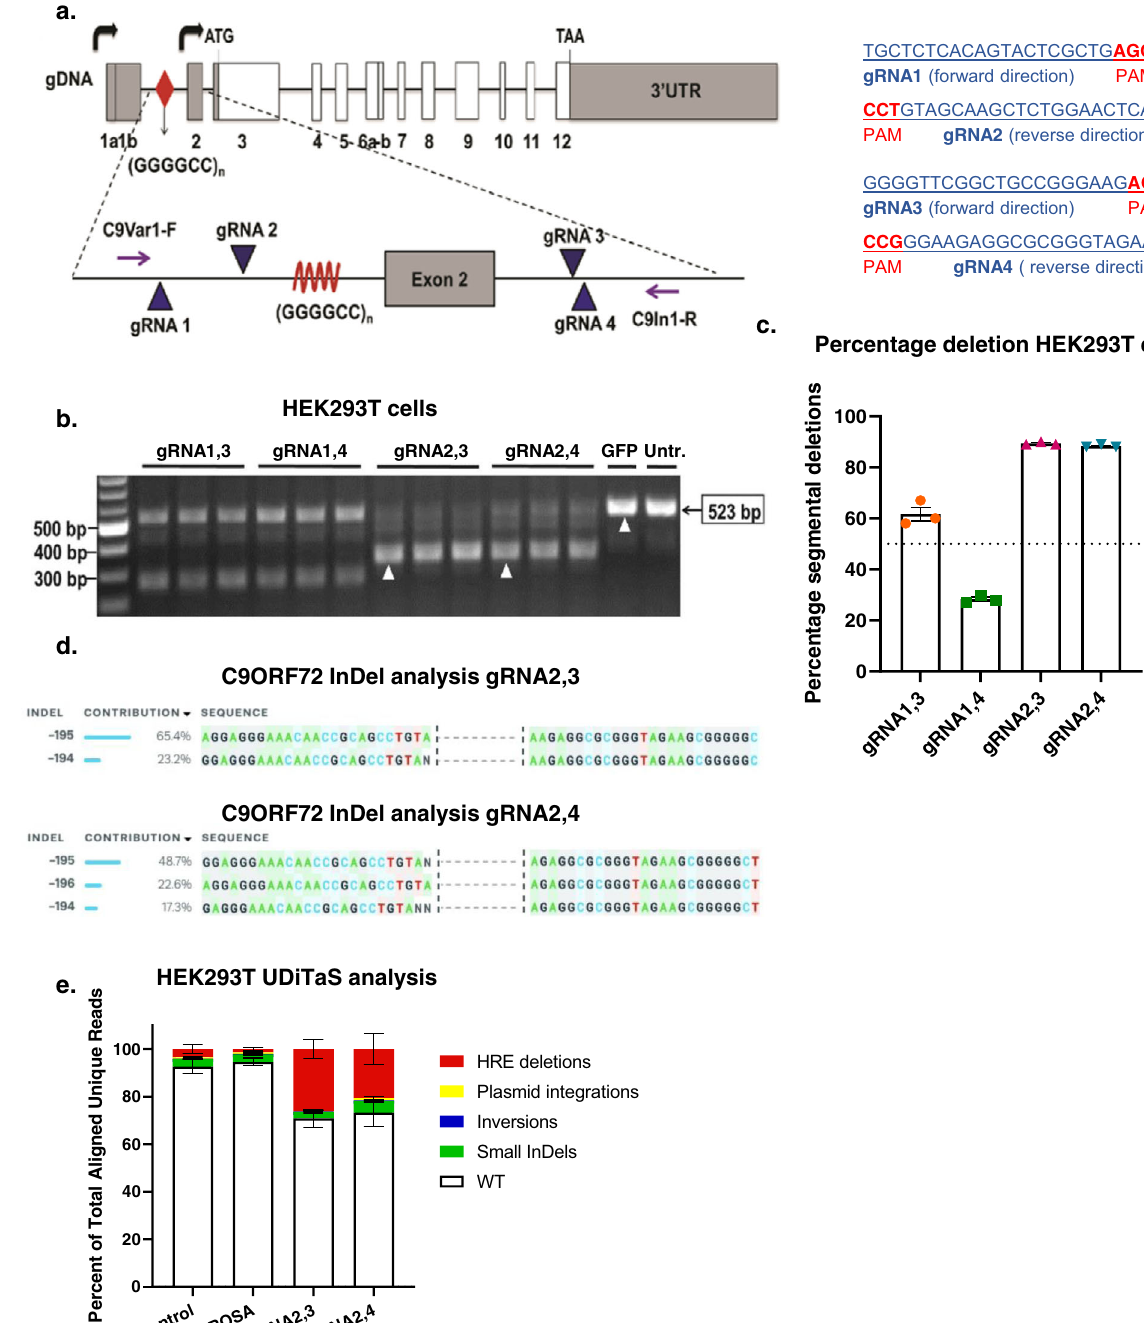
Fig. 1 | Screening of gRNAs fl anking the (GGGGCC) n HRE for excision, in HEK293T cells. a Human C9ORF72 gene showing (GGGGCC) n repeats (red dia- mond) and the locations and sequences of guide RNAs 1, 2, 3, and 4 in addition to primers C9Var1-F and C9In1-R in relation to exon 2 and the (GGGGCC) n repeat. b Screening of gRNAs in HEK293T cells. The CRISPR-targeted C9ORF72 HRE locus was PCR-ampli fi ed by C9Var1-F and C9In1-R primers and PCR products were visualizedbyagarosegelelectrophoresis.TheexpecteduneditedPCRproductsize is 523bp; edited PCR product size for 1 – 3 and 1 – 4 is ~250bp; edited PCR product